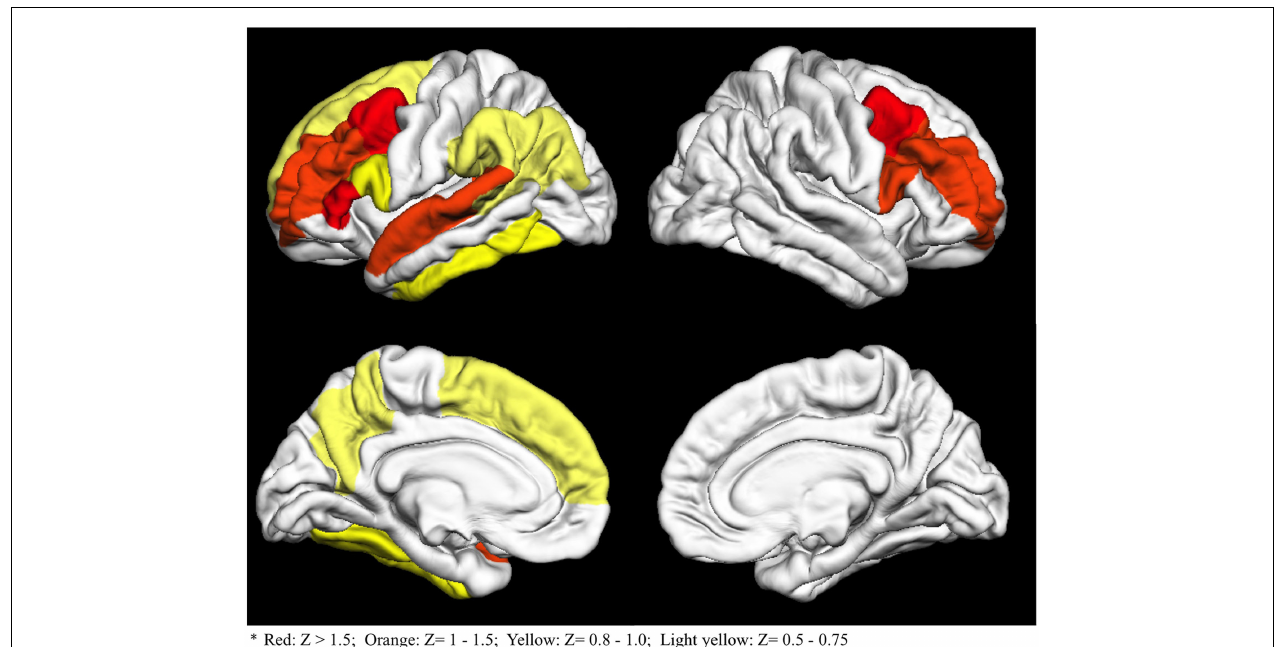
FIGURE 2 | Fifteen cortical regions with importance Z scores at least 0.5 standard deviations above the mean. Colors go from red (high Z scores) to light yellow (lower Z scores)*.